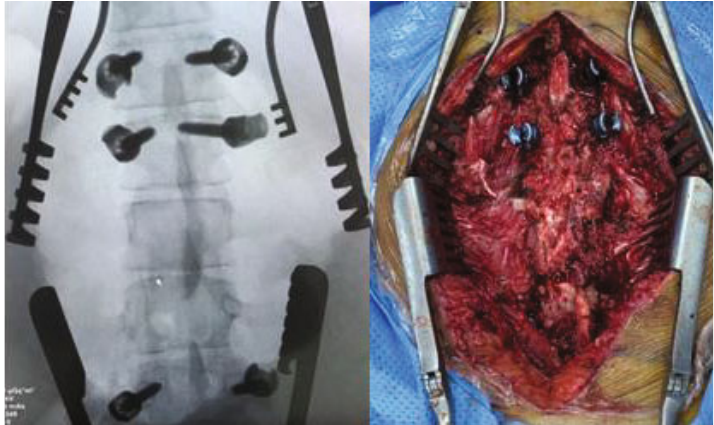
Figure 4: X-ray AP view and intraoperative image post-intrapedicular screw insertion and